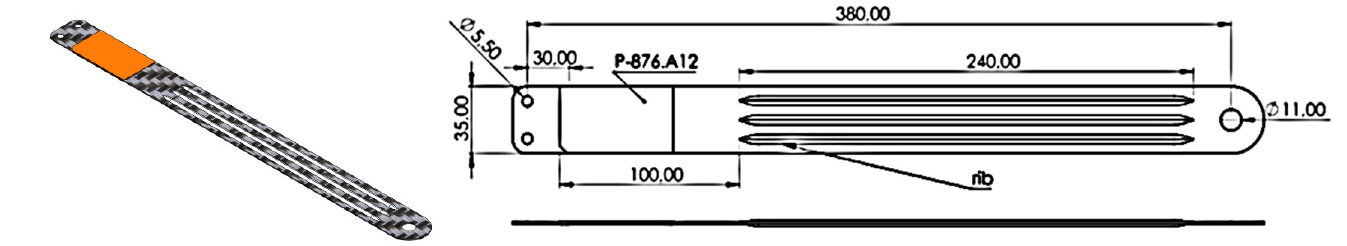
Figure 8. Geometrical characteristics of the deformable band.